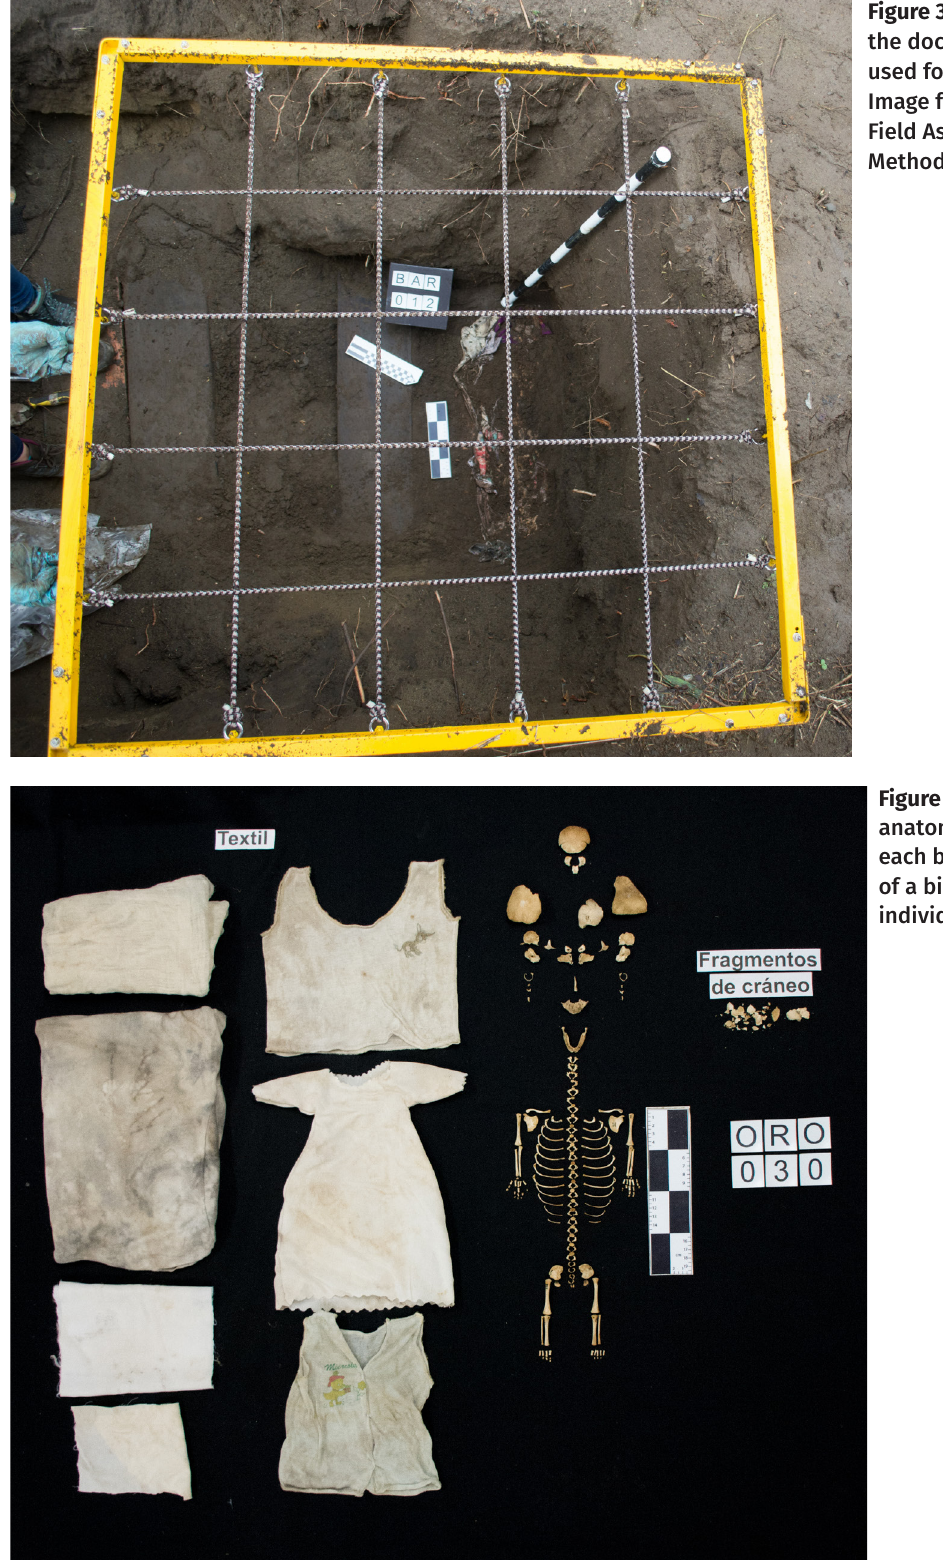
Figure 3. Photograph of the documentation model used for a tomb. Source: Image from the project, Field Assessment Phase